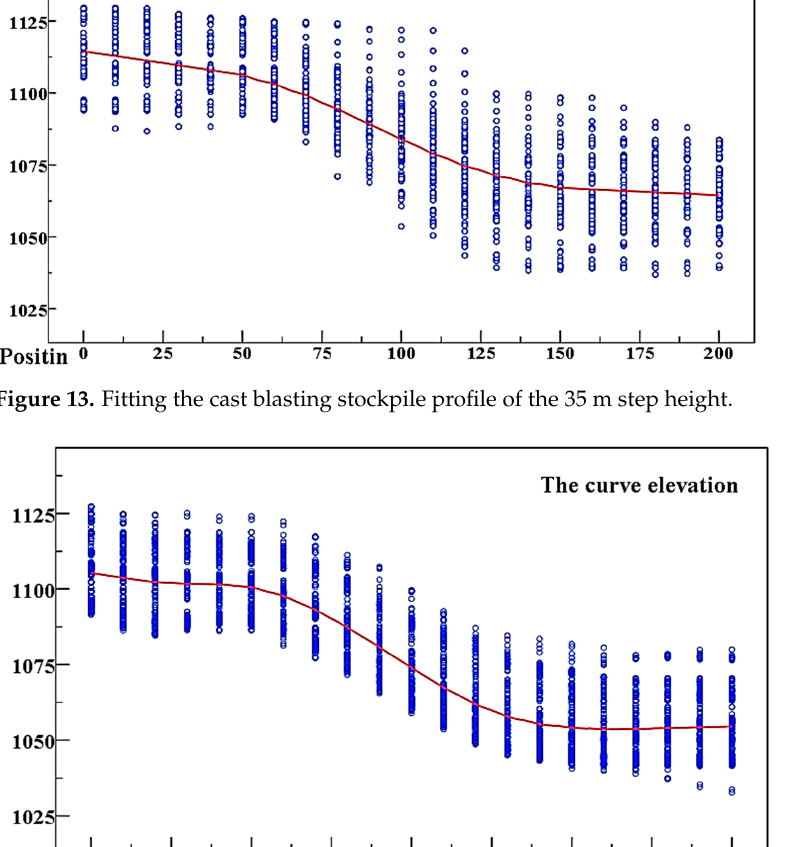
Figure 13. Fitting the cast blasting stockpile profile of the 35 m step height.